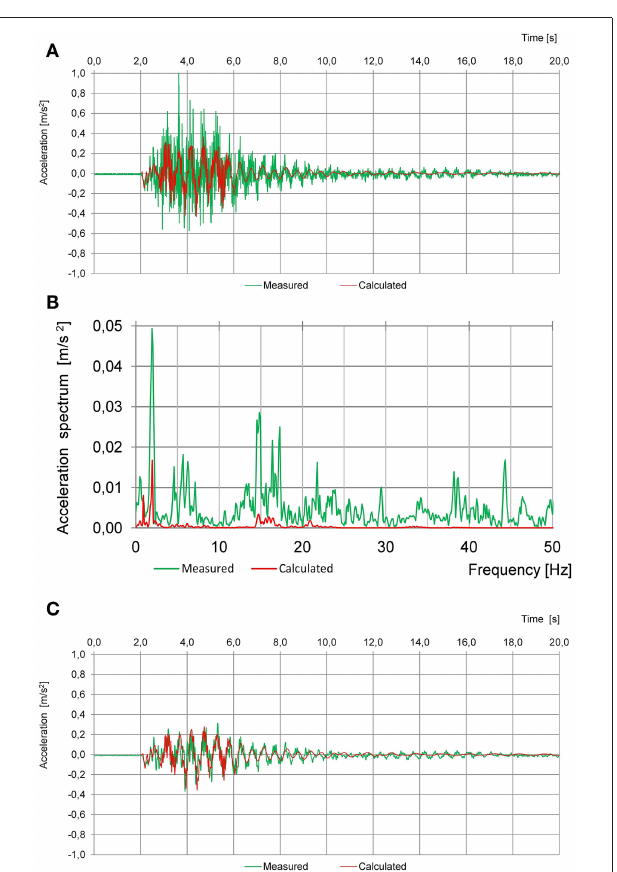
FIGURE 10 | Comparison of the acceleration time history measured during train passage at 200km/h (the same as in Figure 9 ) and determined analytically: (A) acceleration measured using 20Hz Bessel low-pass filter and acceleration calculated without any filters; (B) frequency spectrum from the measured and calculated time history from (A) ; (C) measured and calculated accelerations after using 10Hz Bessel low-pass filter.